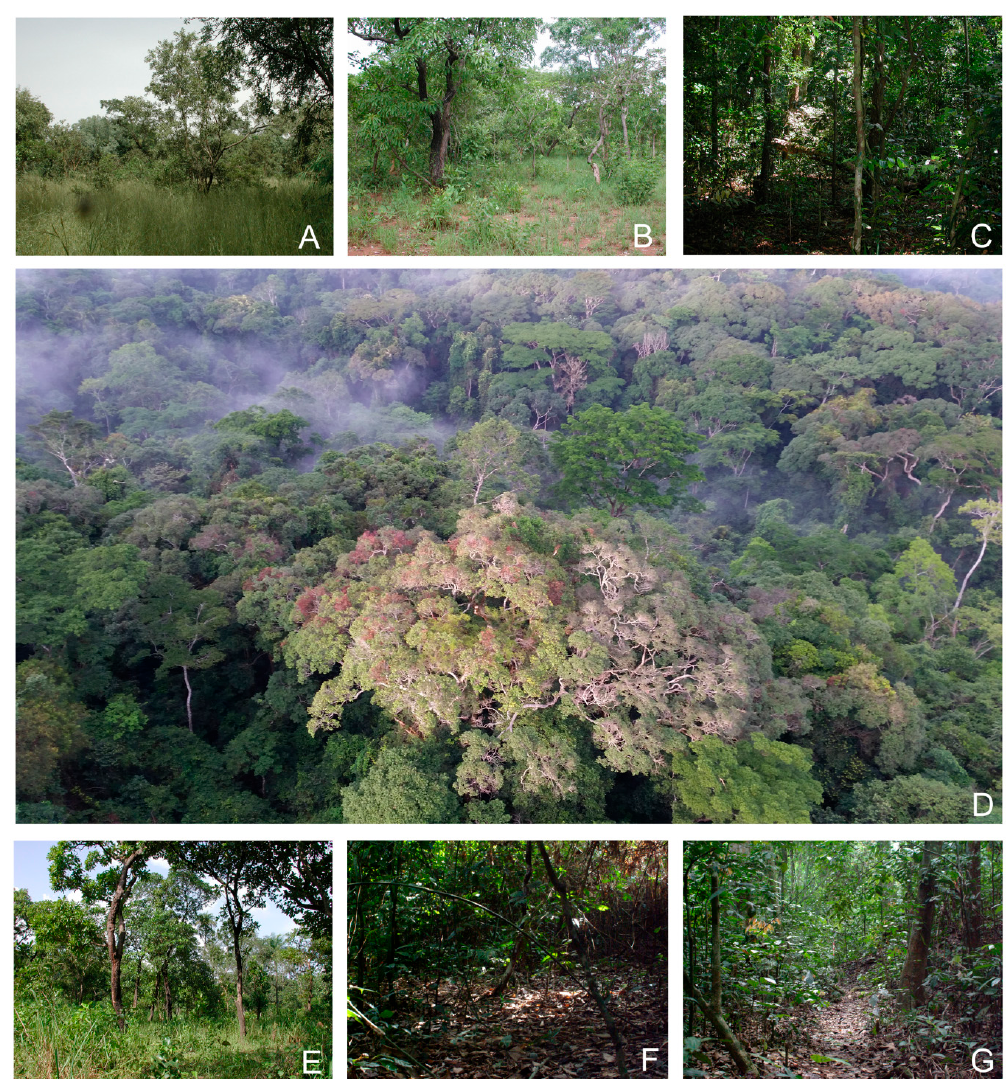
Figure 15. Photos of the habitats of some Tiaronthophagus species (by Philippe Moretto). The species collected in each locality are reported in brackets. ( A ): S é n é gal, Kolda, For ê t de Bakor ( T. chrysoderus